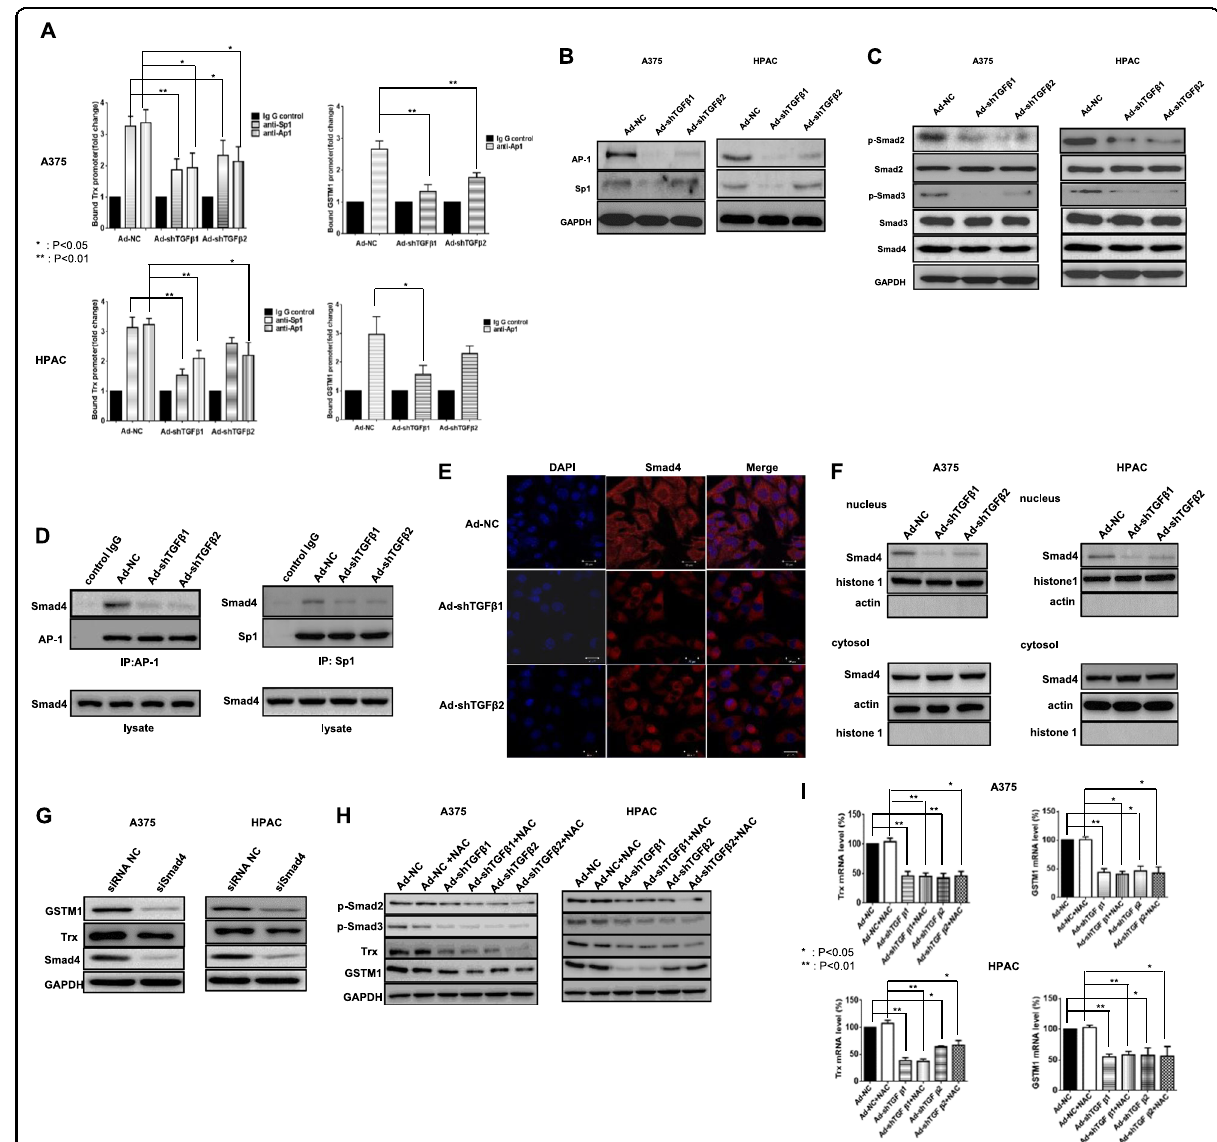
Fig. 5 Regulation of Trx and GSTM1 promoter activity by TGF- β downregulation via a Smad complex. a A375 and HPAC cell lines were infected with adenovirus expressing shTGF- β 1 or - β 2 at 100 MOI, respectively. After 48 h, Trx and GSTM1 promoter activities were analyzed by Chip assays using antibodies to AP-1 or Sp1. Error bars represent the standard error from three independent experiments. Asterisks indicate a signi fi cant difference compared to each given control (* p < 0.05; ** p < 0.01). b A375 and HPAC cells were infected with adenovirus expressing shTGF- β 1 or - β 2 at 100 MOI, respectively. After 48 h, the expression levels of AP-1, Sp1 and GAPDH were detected by western blot analysis using whole-cell lysates. c p-Smad2, Smad2, p-Smad3, Smad3, Smad4, and GAPDH were detected by western blot analysis. d A375 cells were infected with adenovirus expressing shTGF- β 1 or - β 2 at 100 MOI. After 48 h, lysates were then subjected to immunoprecipitation with an anti ‐ AP1 or anti-Sp1 antibody to identify changes in Smad4 in complex formation. e A375 cells were infected with adenovirus expressing shTGF- β 1 or - β 2 at 100 MOI. After 48 h, Smad4 localization was examined by confocal immuno fl uorescence staining. Representative confocal immuno fl uorescence staining of each infected A375 was performed as described in the Materials and methods section to con fi rm the localization of Smad4. f A375 and HPAC cells were infected with adenovirus expressing shTGF- β 1 or - β 2 at 100 MOI, respectively. After 48 h, Smad4 localization was examined in nuclear or cytosolic fractionation using nuclear (histone 1) or cytosol (actin) markers. g A375 and HPAC cell lines were transfected with negative control siRNA or Smad4 siRNA. After 48 h, transfected cells were detected with GSTM1, Trx, Smad4, and GAPDH. h Effects of NAC on Trx and GSTM1 expression in melanoma and pancreatic cancer cells expressing shTGF- β 1 or - β 2 adenovirus. A375 and HPAC cells were infected with adenovirus expressing shTGF- β 1 or - β 2 at 100 MOI, respectively. After 6 h, infected cells were treated with NAC (10 mM) for 42 h. Then, p-Smad2, p-Smad3, Trx, GSTM1, and GAPDH were detected by western blot analysis. i A375 and HPAC cells were infected with adenovirus expressing shTGF- β 1 or - β 2 at 100 MOI, respectively. After 6 h, infected cells were treated with NAC (10 mM) for 42 h. Then the expression levels of Trx and GSTM1 mRNA were assayed by quantitative real-time polymerase chain reaction (qRT-PCR). Error bars represent the standard error from three independent experiments. Asterisks indicate a signi fi cant difference compared to each given control (* p < 0.05; ** p <